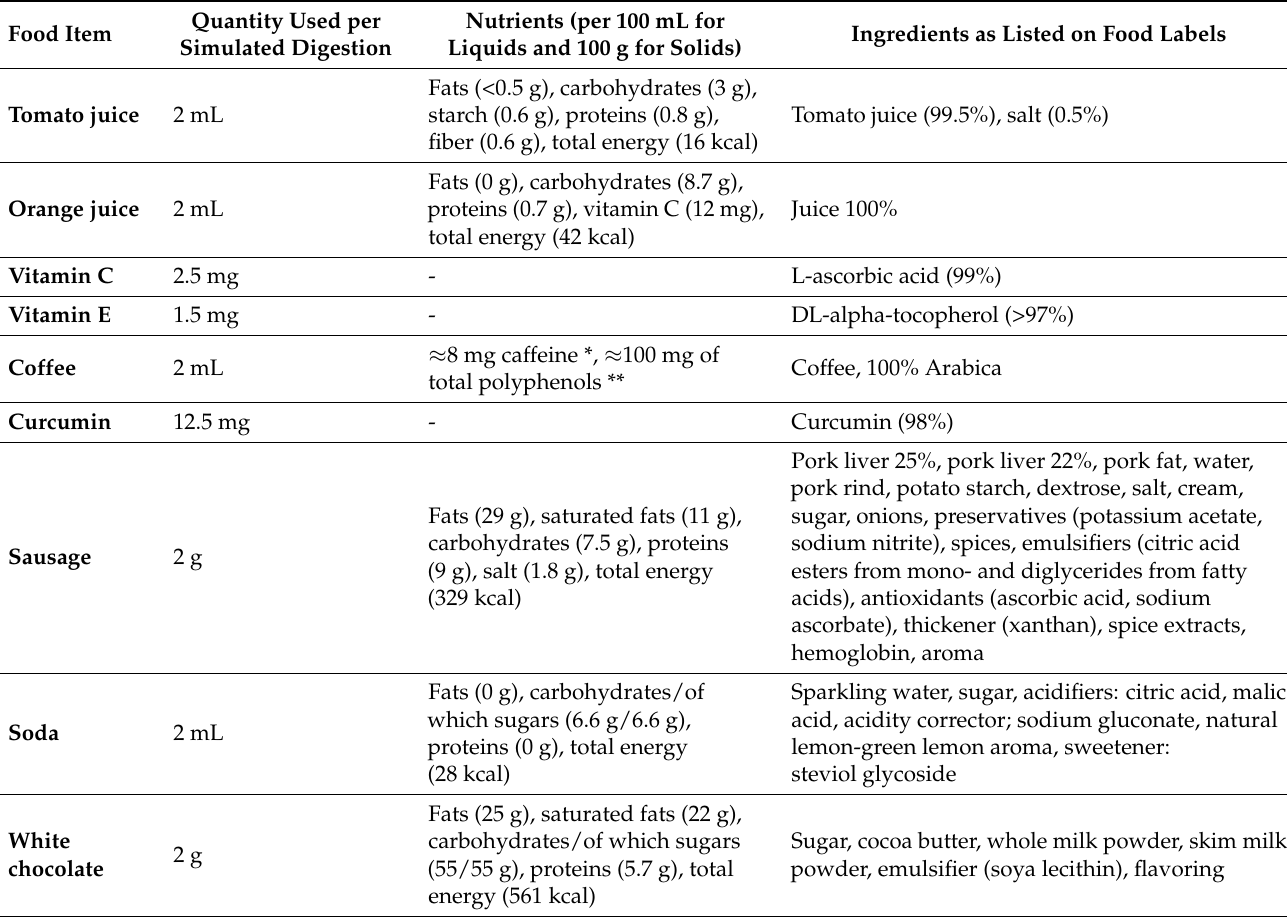
Table 1. Selected food items, their quantity, and